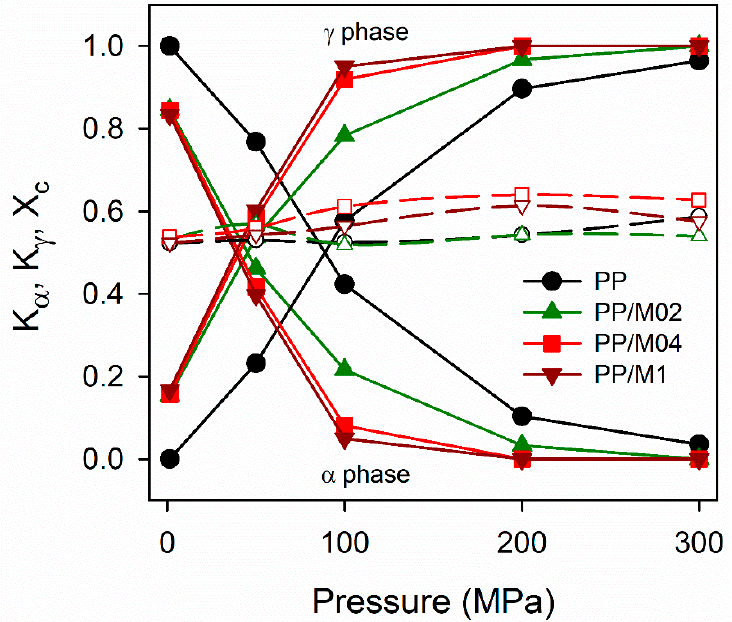
Figure 4. Phase contents in crystalline phase, K α and K γ (solid lines, filled symbols), and crystallinity degree, X c (dashed lines, empty symbols), of neat and nucleated PP crystallized during cooling, according to protocol I, vs. pressure.